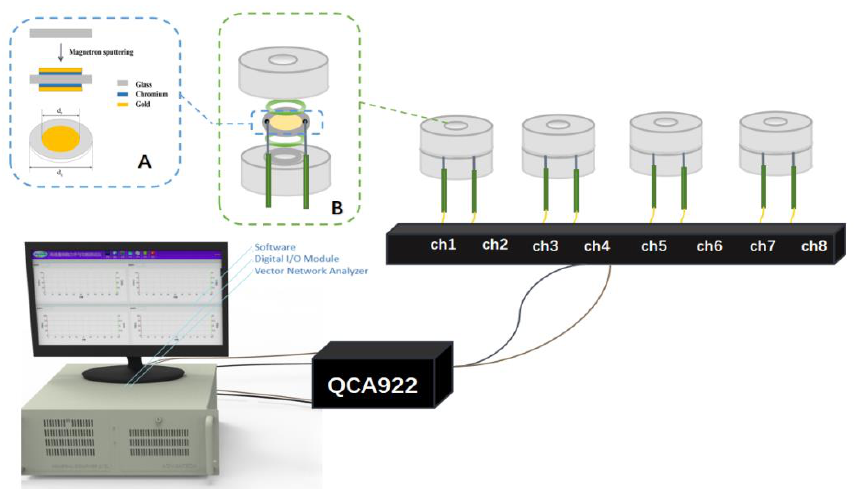
Figure 1. Diagram of the QCM unit (( A ): process flow and diagram of the QCM piezoelectric resonator; ( B ): diagram of the Teflon well cell assembly).